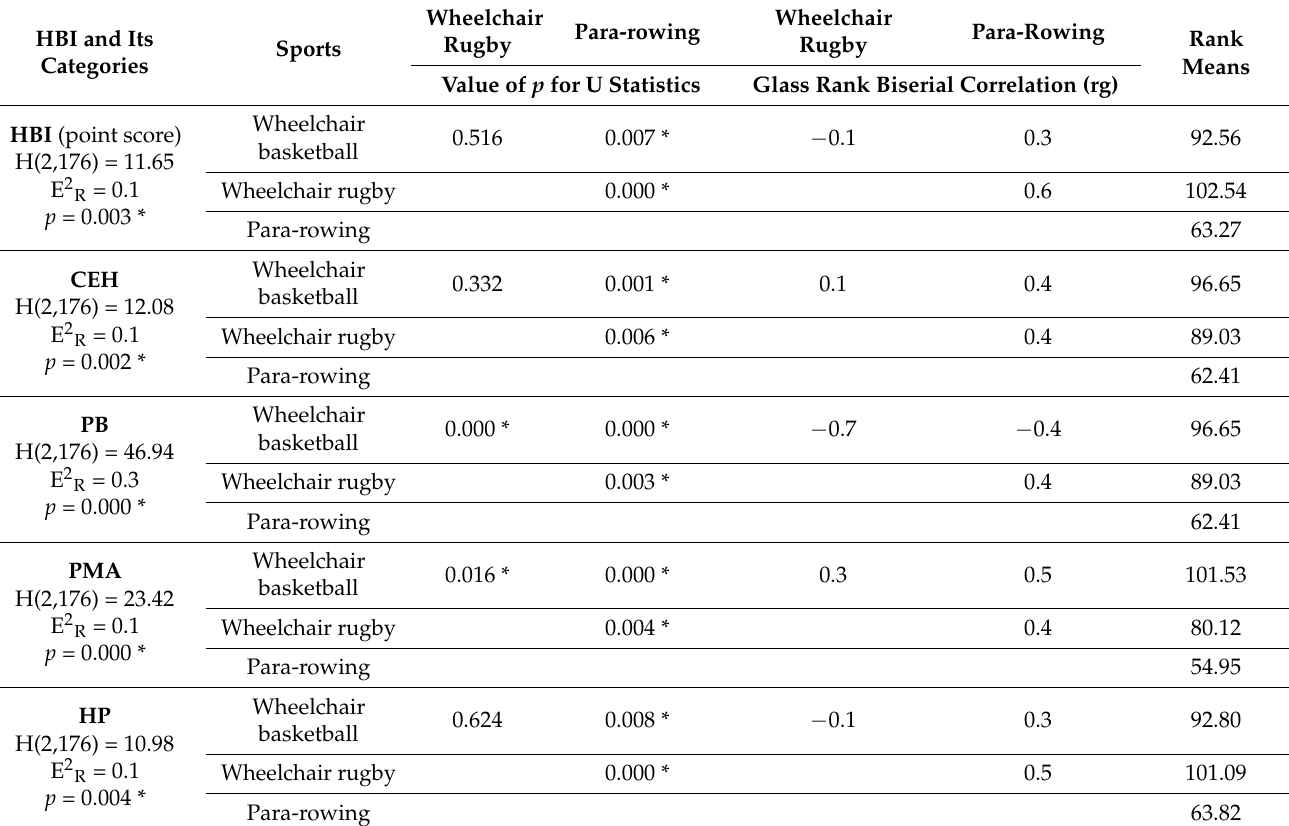
Table 2. Health behaviors of people practicing wheelchair basketball, wheelchair rugby and rowing (the H test, E 2 R , the U test, rg).